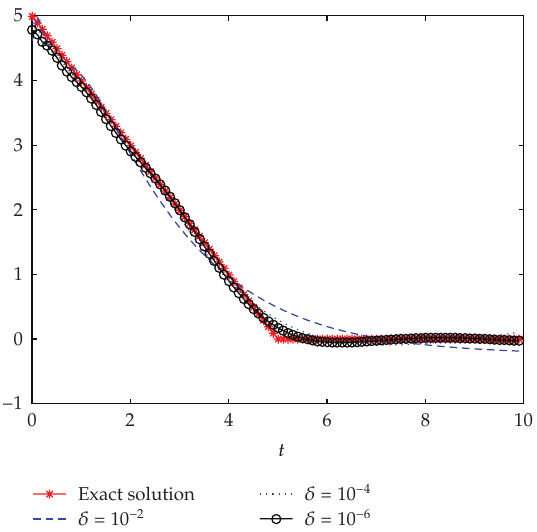
Figure 9: Example 3.9: the stability of the approximate solution.